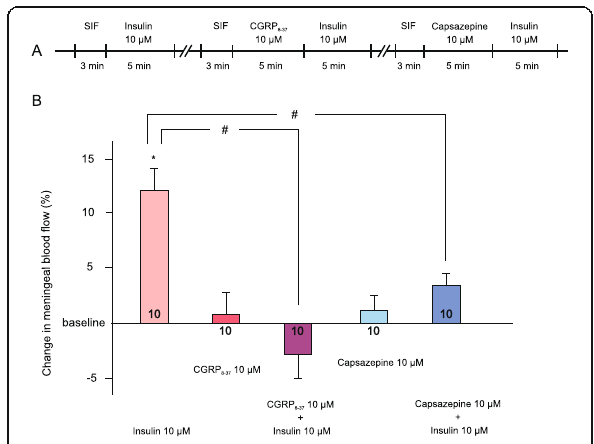
Fig. 2 Changes in meningeal blood flow induced by topical application of insulin. ( A ) Flowchart summarizing the experimental protocol. ( B ) Blood flow increasing effect of insulin (10 μ M for 5 min) before and after CGRP 8 – 37 or capsazepine (both at 10 μ M for 5 min) applied topically to the dura mater. Effects of CGRP 8 – 37 and capsazepine applications alone are also demonstrated. The number of measurements is indicated in the bars. *: statistically different from the basal flow. #: statistically different from the effect without pretreatment